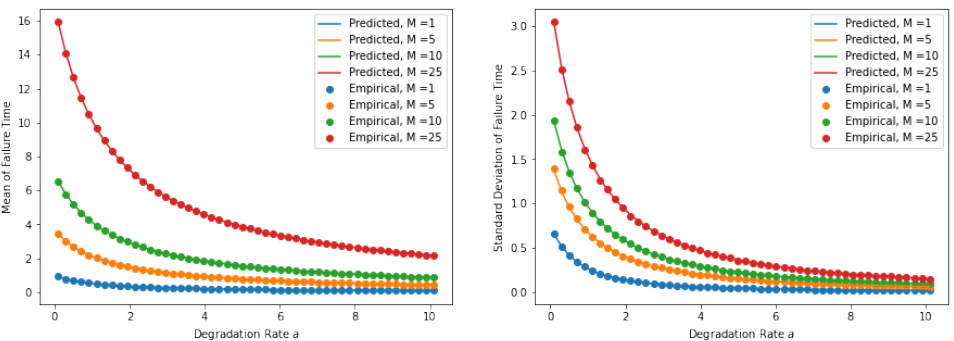
Figure 3. Predicted and empirical values for the mean and standard deviation of the failure